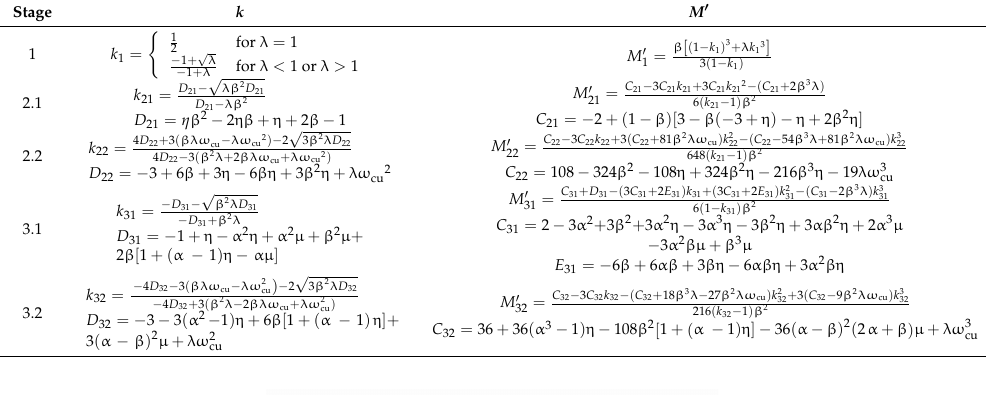
Table 3. Solutions of the neutral-axis depth ratio and normalized moment, and the curvature for each stage of applied strain at the most tensile fiber ( β ).